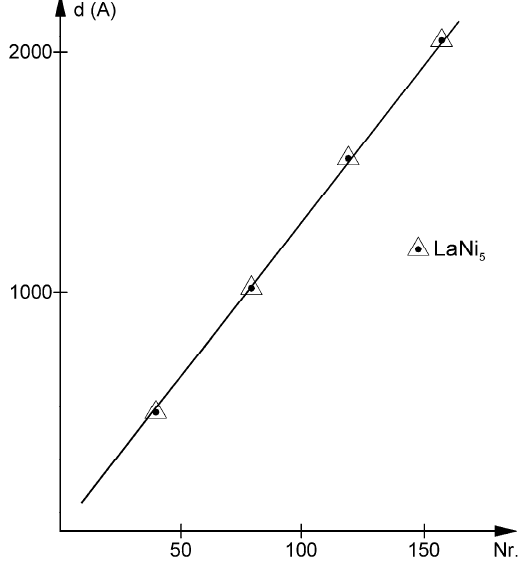
Figure 2. Dependence of the LaNi 5 film thickness vs. laser impulses number.